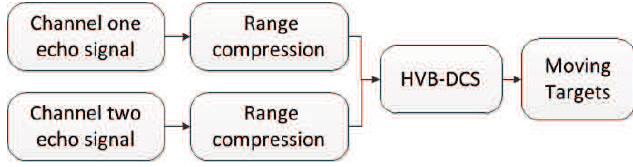
Figure 10. Flow chart of the HVB-DCS based GMTI